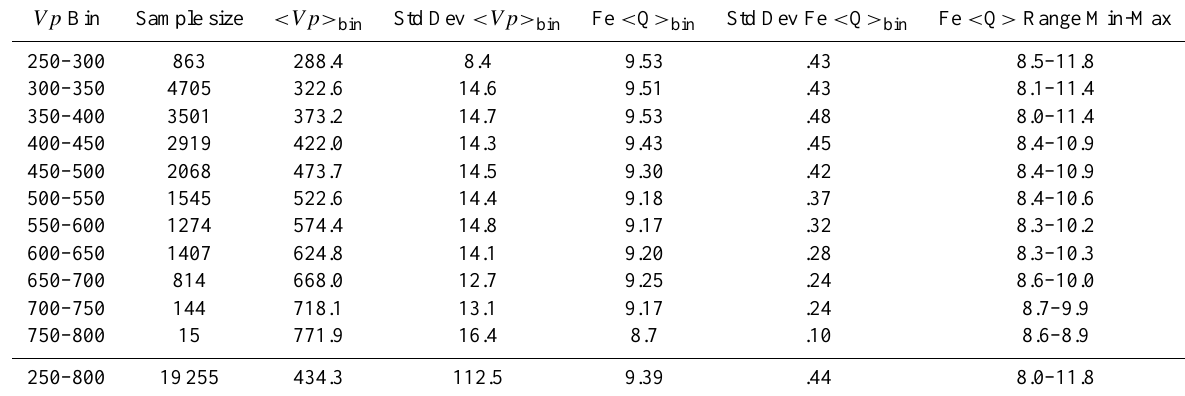
Table 2. Coronal hole-associated and slow solar wind: iron average charge states binned by proton speed. Vp